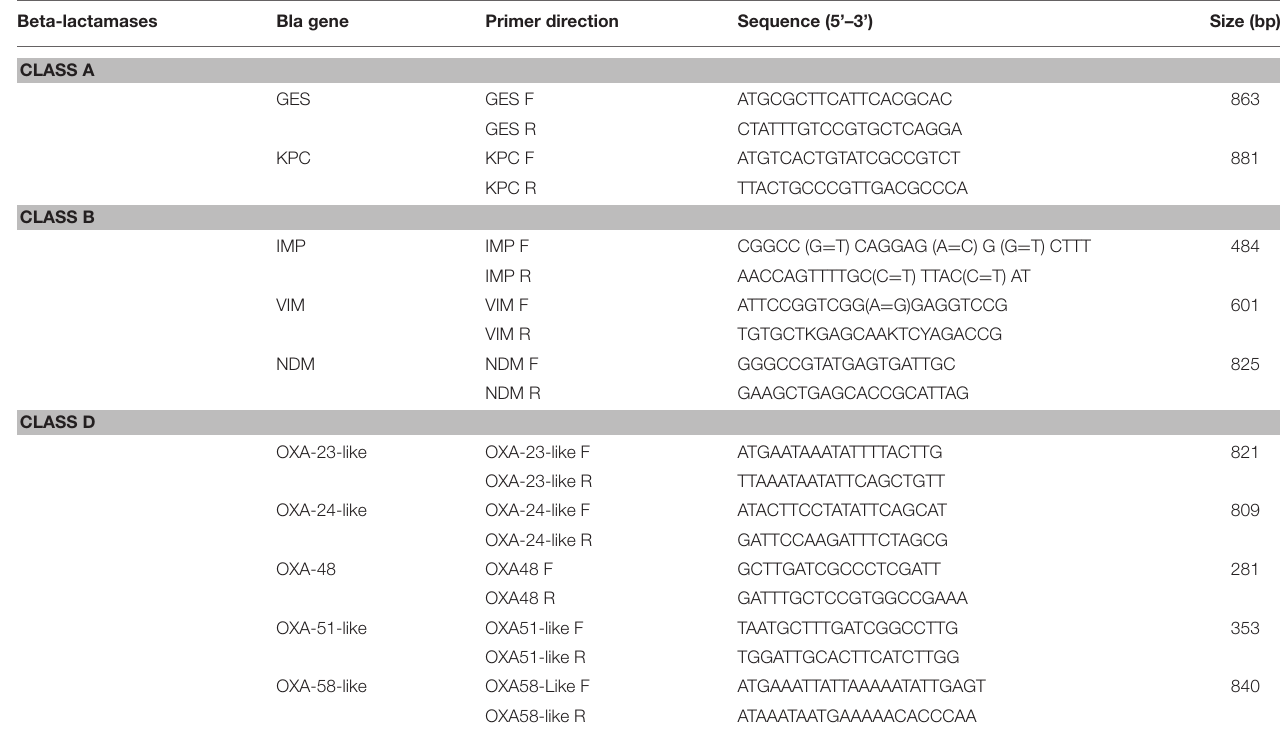
TABLE 1 | primers used for PCR amplification with their different amplicon size.